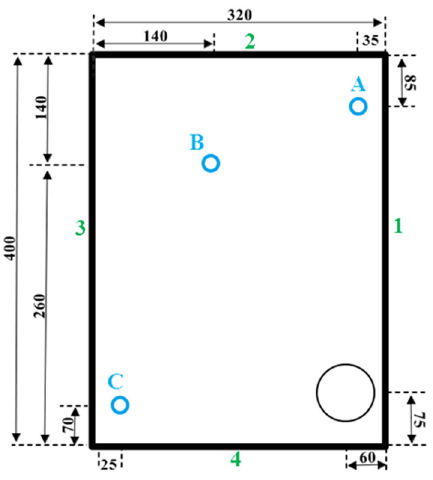
Figure 6. Isabelle Sochet experimental layout diagram.